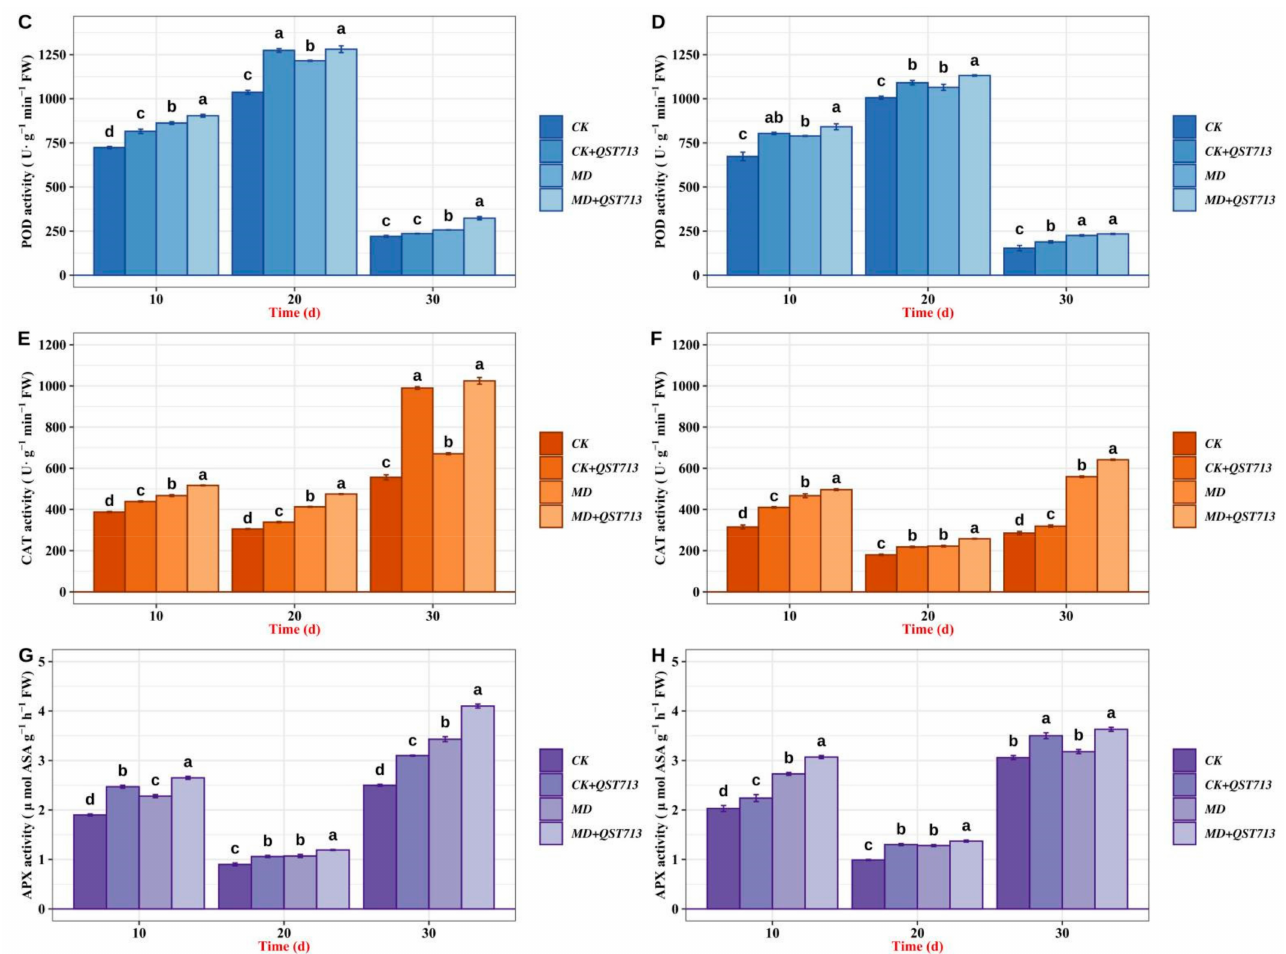
Figure 5. Effect of drought stress and QST713 application on antioxidative enzyme activities of SOD ( A , B ), POD ( C , D ), CAT ( E , F ) and APX ( G , H ) in leaves of alfalfa seedlings in two cultivars (( A , C , E , G ), Galalxic Max; ( B , D , F , H ), Saidi 7). Data are the mean ± SE ( n = 3). Different letters indicate significant differences from each other ( p <